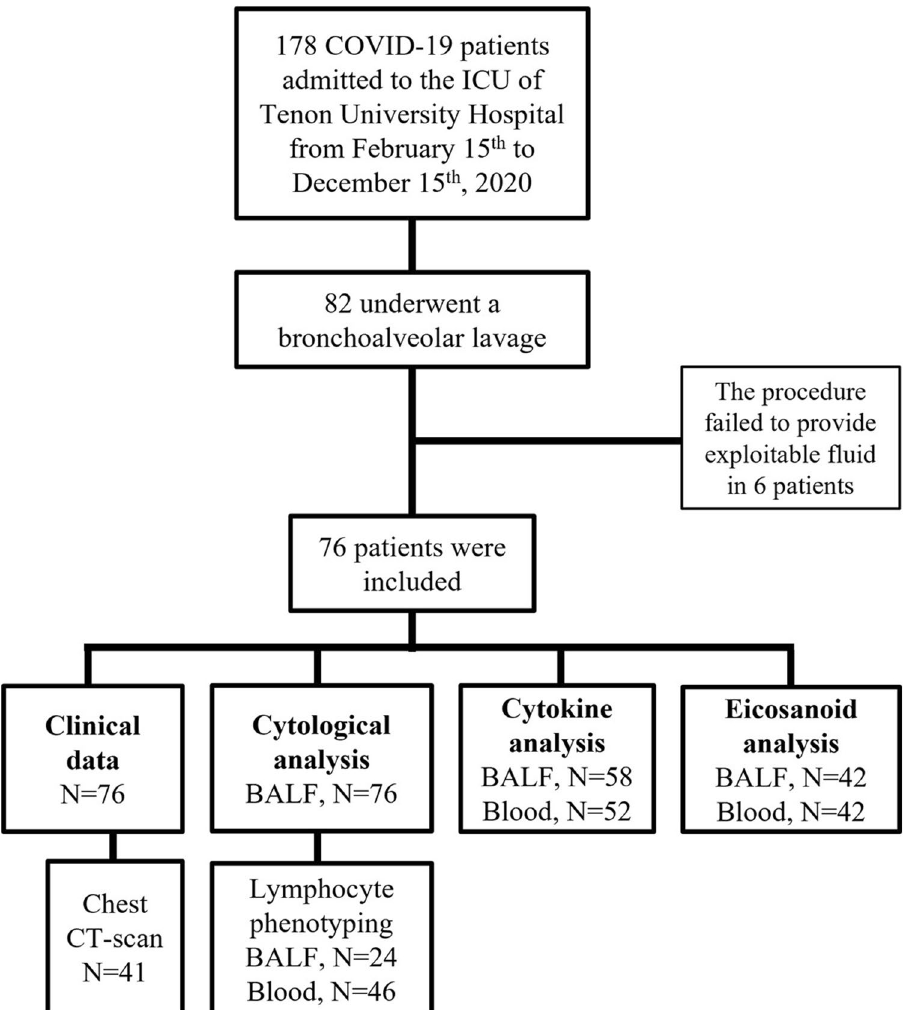
Figure 1. Flowchart. BALF bronchoalveolar lavage fluid, Chest CT-scan chest computed tomography scan, ICU intensive care